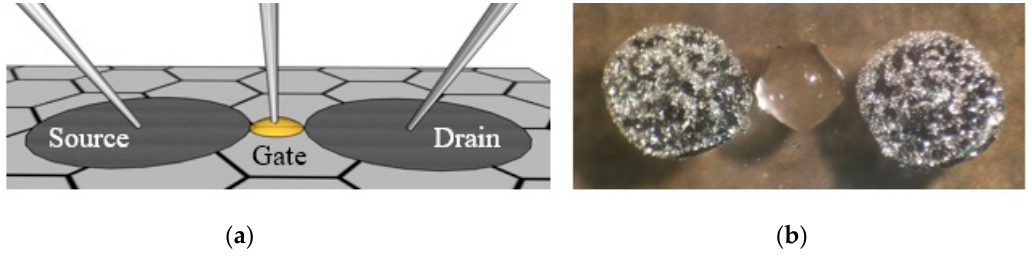
Figure 4. ( a ) Illustration and ( b ) picture of graphene field-effect transistor with spray-on liquid-metal electrodes and honey gate dielectric.